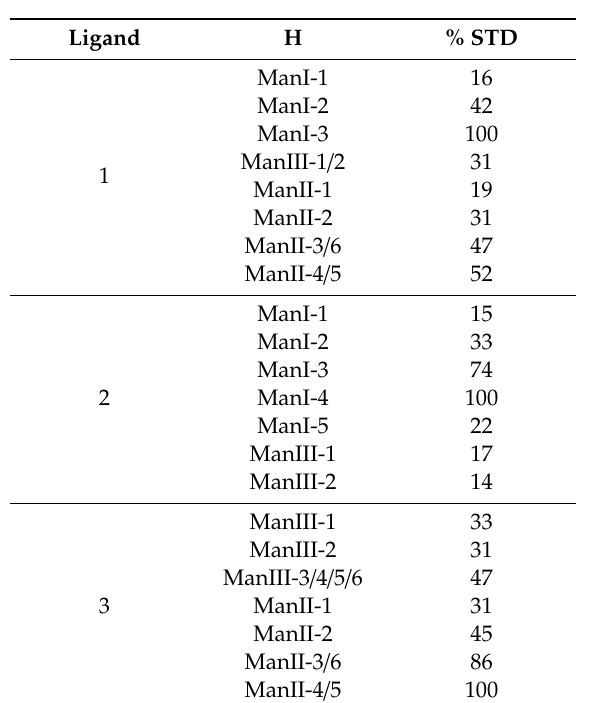
Table 1. Normalized STD NMR data from 2D-STD-TOCSYreF experiments for the fluorinated glycomimetics 1 - 3